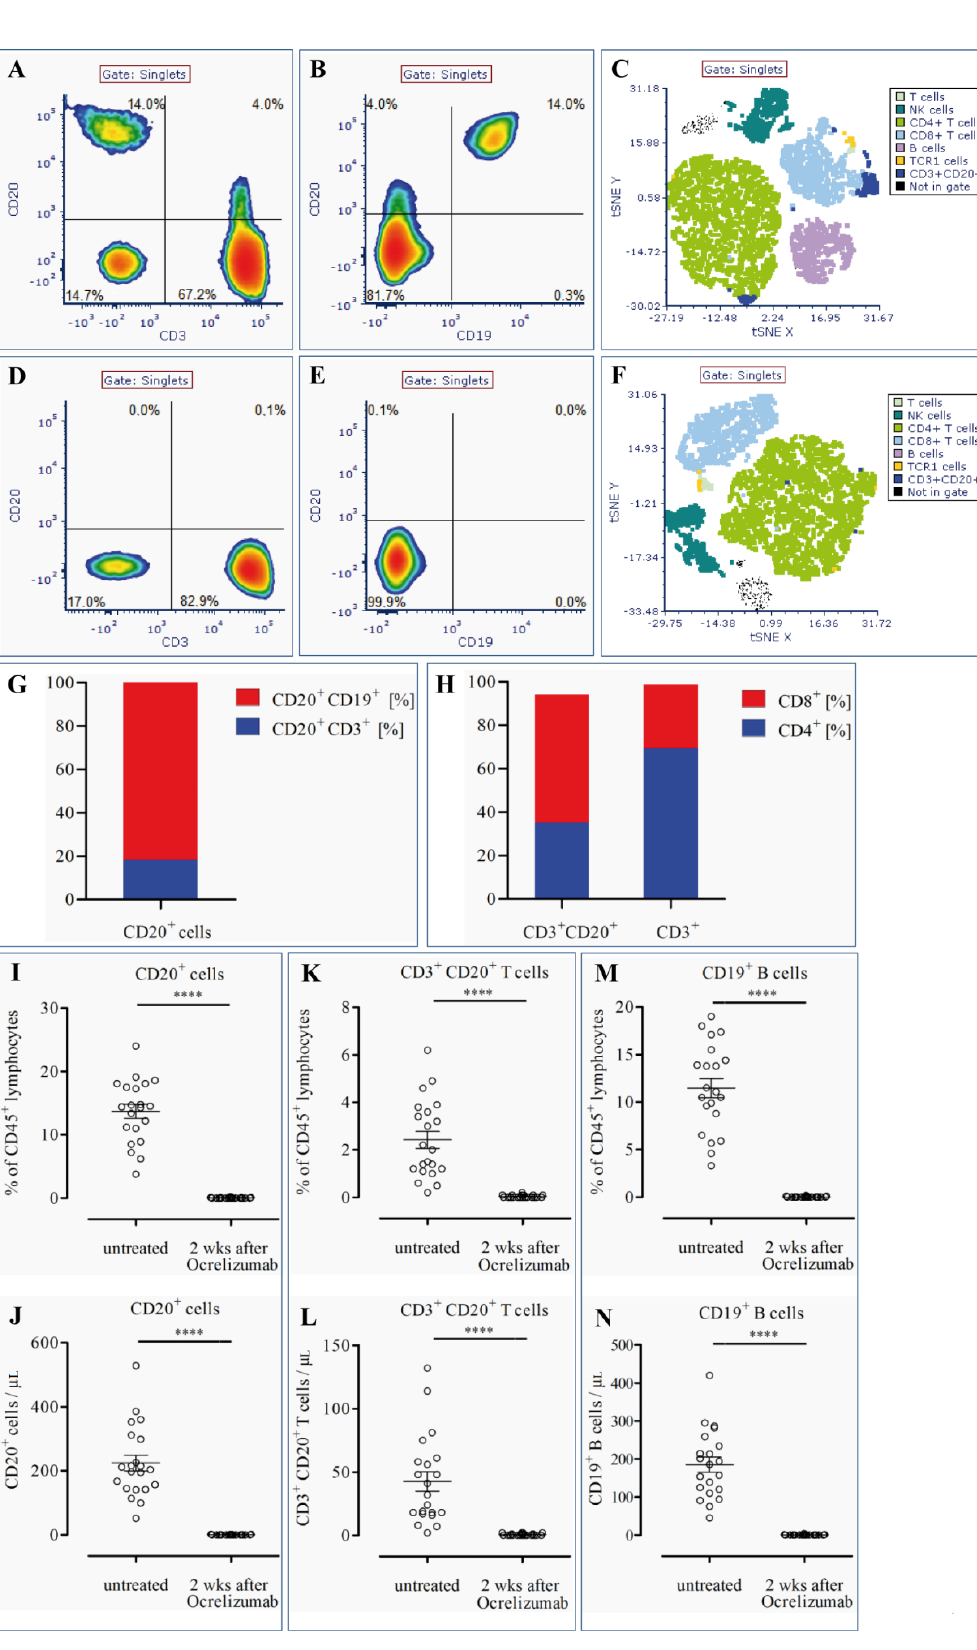
Figure 1. Detection of CD3 + CD20 + T lymphocytes in peripheral blood of MS patients and depletion by